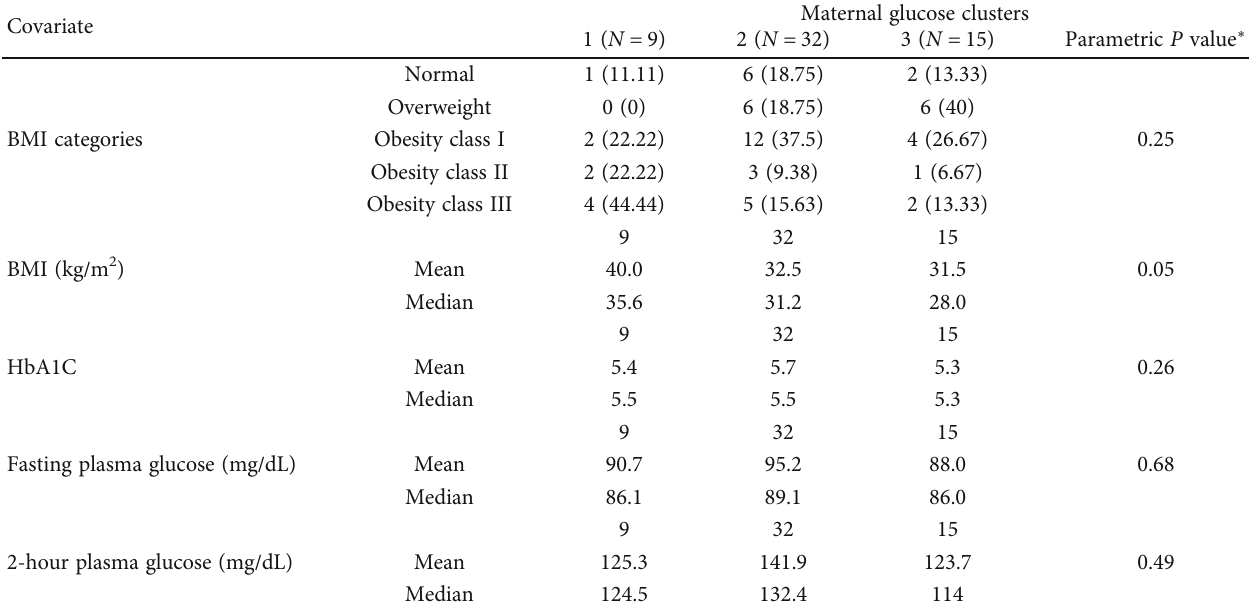
Maternal glucose